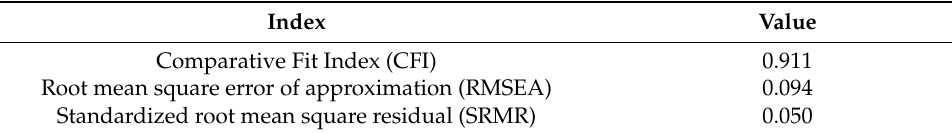
Table 5. Fit indices—CFA across sex.